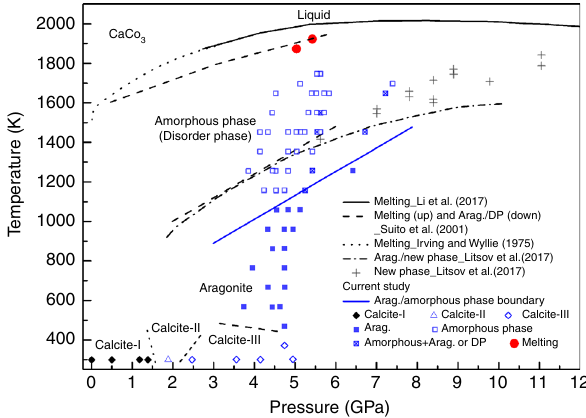
Fig. 2 Phase diagram of CaCO 3 at high pressure and high temperature. Arag. and DP represent aragonite and disorder phase, respectively. The black diamond and colored symbols show current data. The phase boundaries of calcite-I, calcite-III, calcite-II, and aragonite are drawn according to Suito et al. 20 . Other symbols and curves are from Irving and Wyllie 57 , Suito et al. 20 , Litasov et al. 25 , and Li et al.